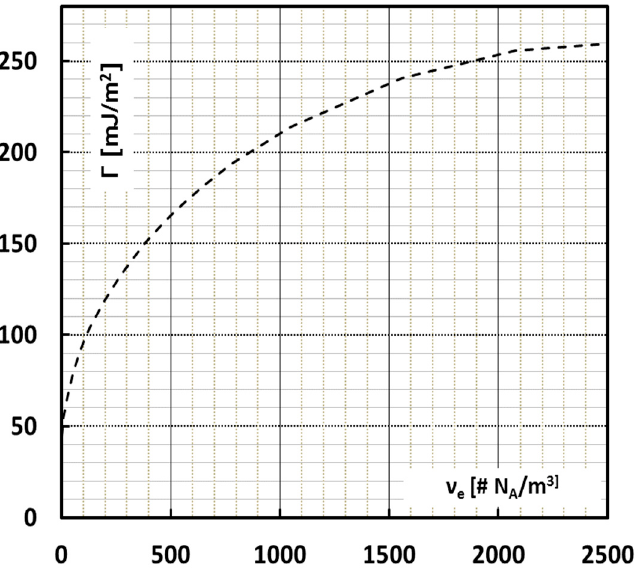
Figure 5. Surface energy Γ as a function of the effective network node density expressed in multiples of Avogadro’s number assuming the Porod worm chain model of Equation (6).